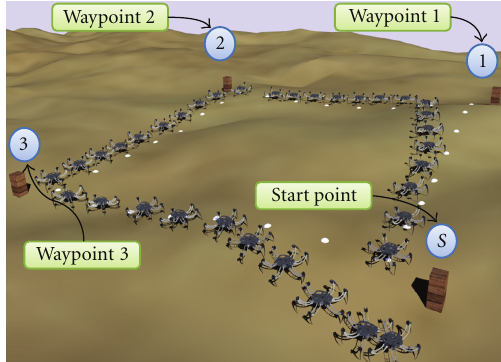
Figure 10: Pictorial representation of the path traced by the robot without using the FRC